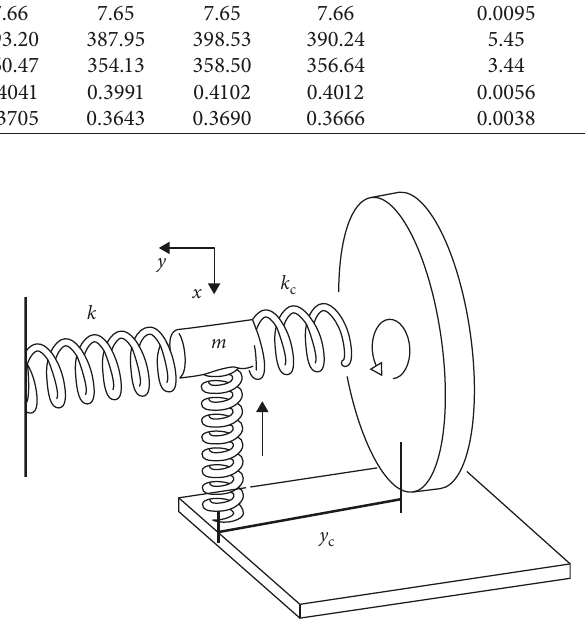
Figure 4: Schematic model of pad-disk interface of an idealized